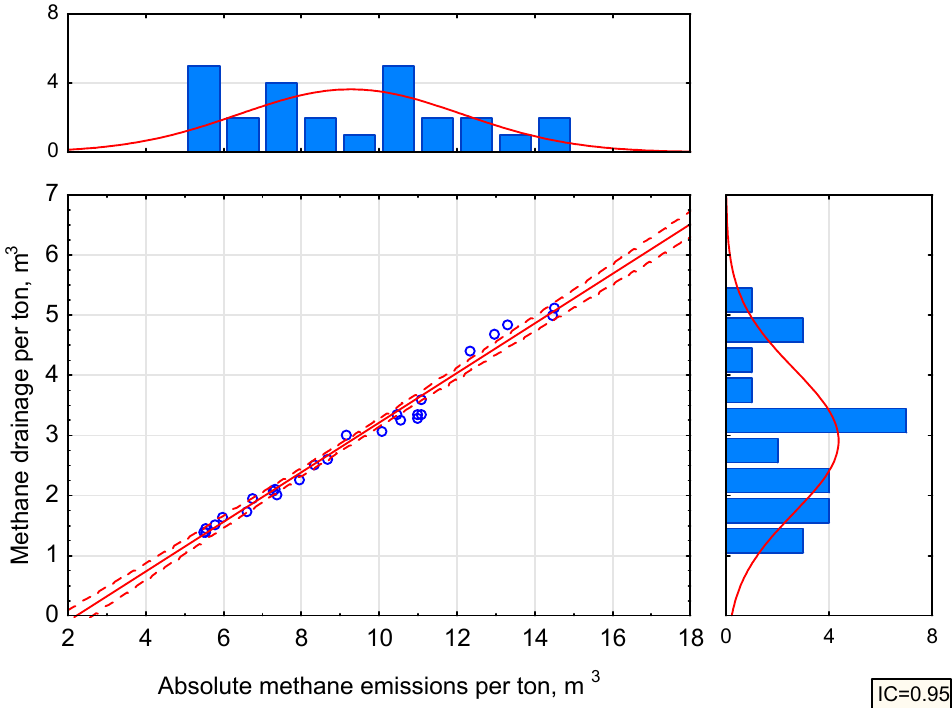
Figure 10. Relationship between absolute methane emissions and methane drainage per one ton in hard coal mines in Poland.